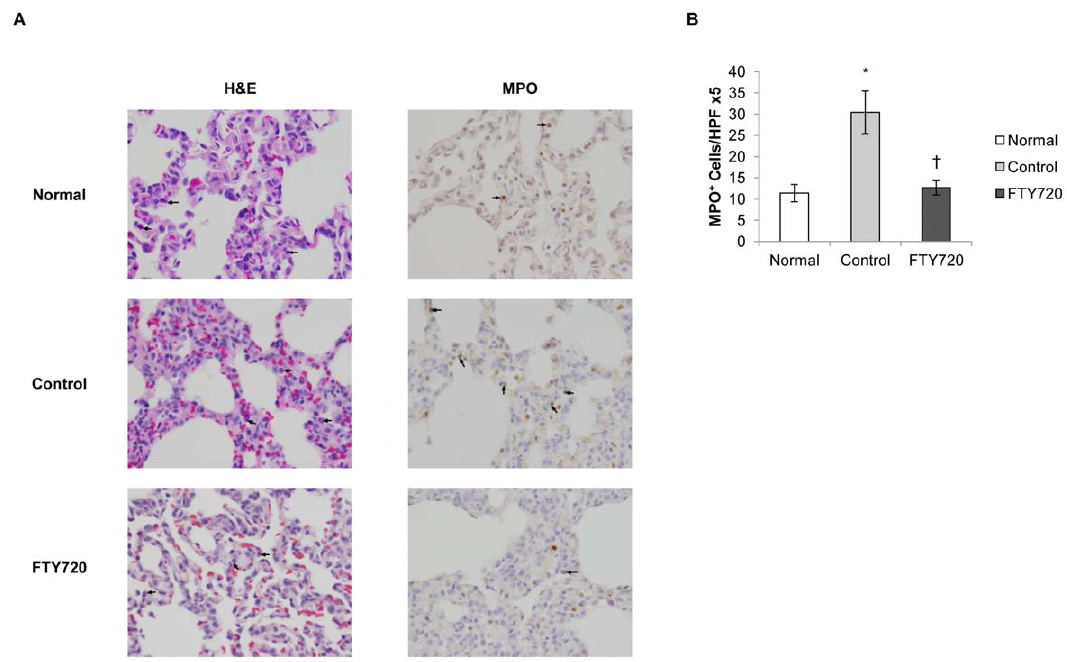
Figure 7. Lung tissue neutrophil infiltration at time of necropsy. a ) Representative histology pictures (400 6 magnification) of normal, control and PATG tissue. b ) Quantification of anti-MPO reactivity. * indicates p , 0.05 compared to normal, unmanipulated tissue. { indicates p , 0.05 compared to control group. Data is depicted as mean 6 SEM.